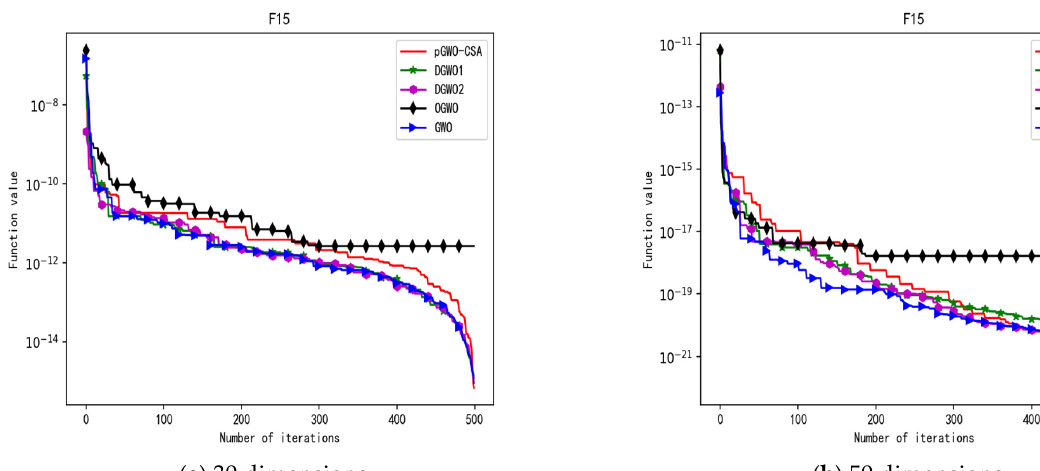
Figure 34. Convergence curve of test function